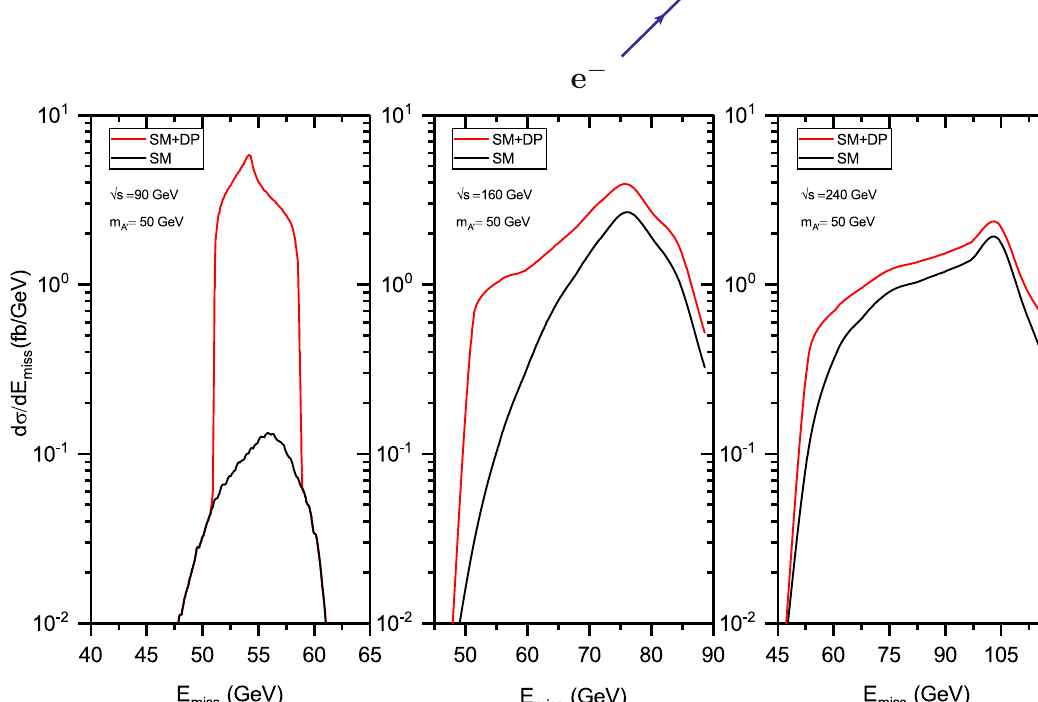
Fig. 6 The differential cross sections for the unpolarized γ e − → e − + E / scattering at the collider CEPC. The mixing parameter is fixed to be ε = 0 .